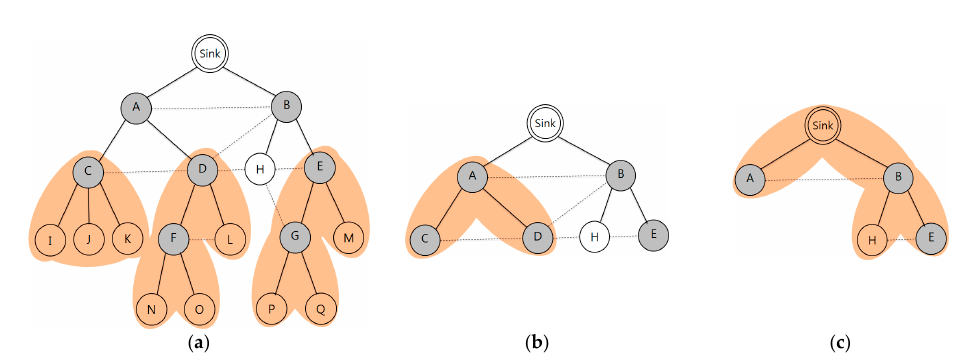
Figure 3. Example: channel assignment sequence by subtree: ( a ) a channel assigned to nodes C, D, E, F, and G; ( b ) a channel assigned to node A; and ( c ) a channel assigned to node B and the sink.